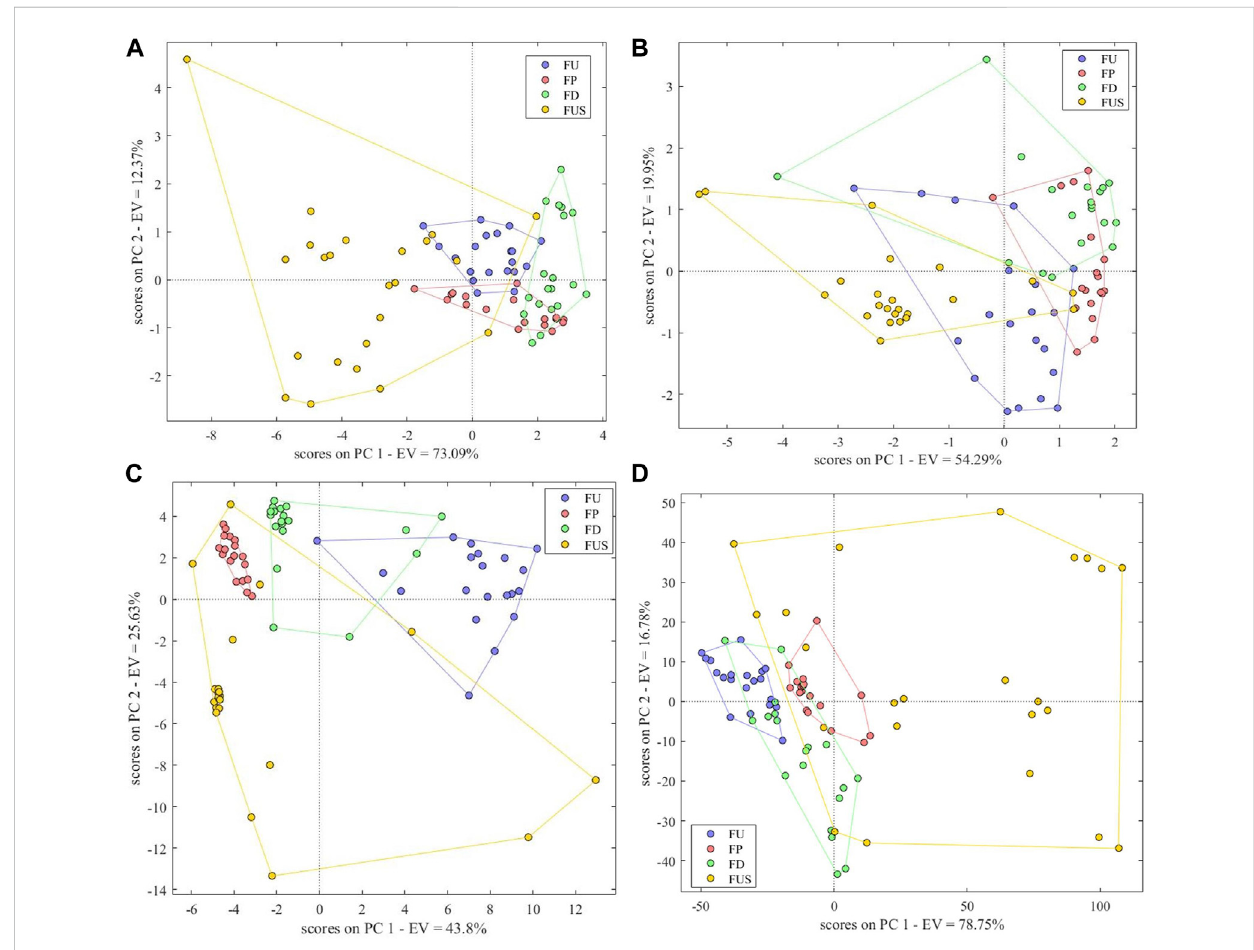
FIGURE 7 ScoresPlotofSingle-SourcePCA-DAspeciesidenti fi cationmodelbasedon (A) electronicnose, (B) electronictongue, (C) electroniceyeand (D) NIR